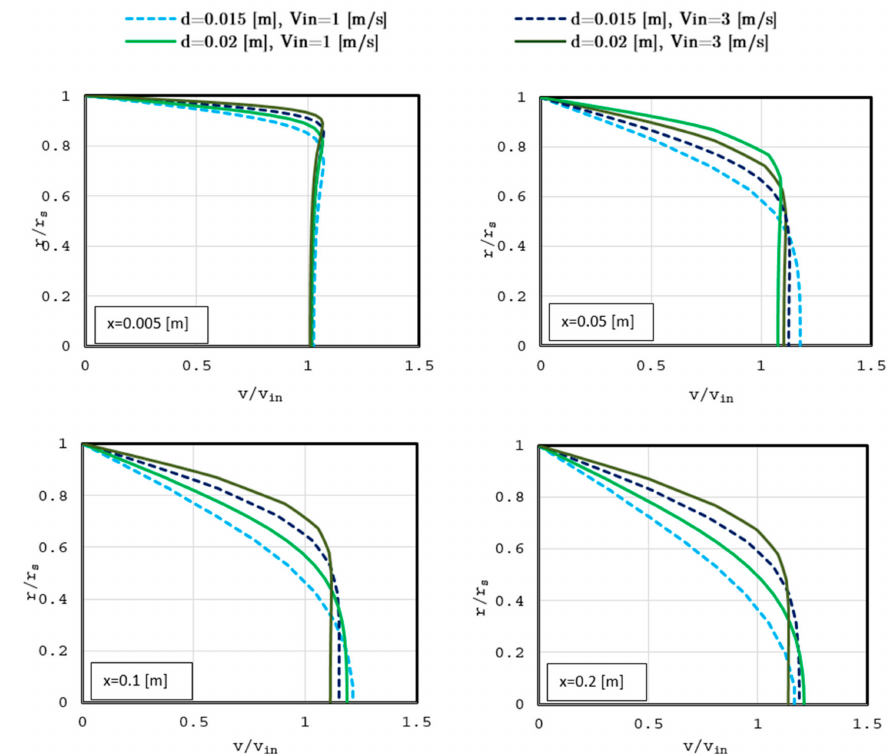
Figure 6. Results of the conjugate heat-transfer analysis: velocity profiles at di ff erent